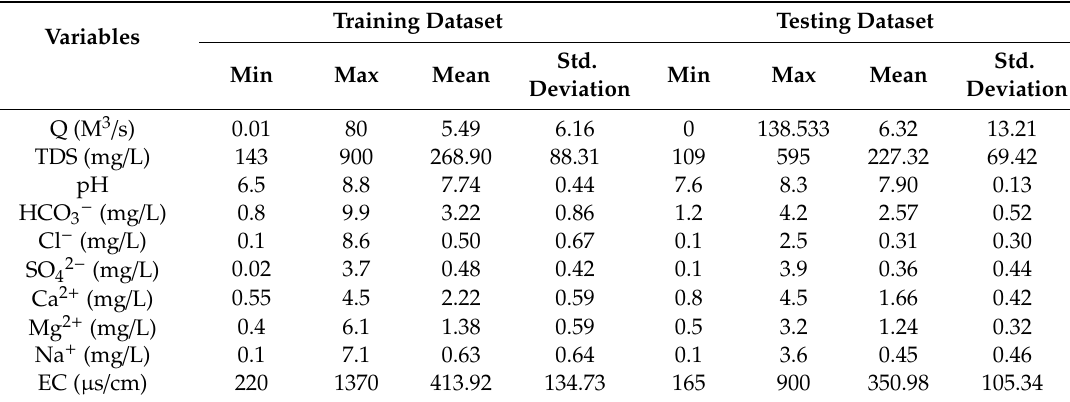
Table 1. Statistics of the training and testing